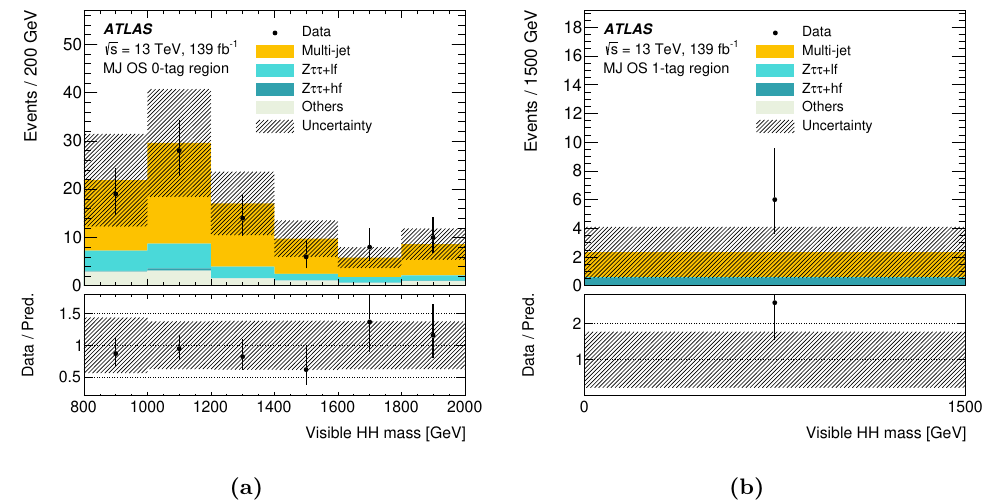
Figure 7. Distribution of m vis in two regions enriched in multi-jet events, (a) ‘MJ OS 0-tag’ and HH (b) ‘MJ OS 1-tag’ in table 2. The background referred to as ‘Others’ contains W +jets, diboson, ZH , t ¯ t and single-top-quark events. The lower panels show a bin-by-bin comparison of the data and the predicted total background, in terms of event yield ratios. The hatched bands represent combined statistical and systematic